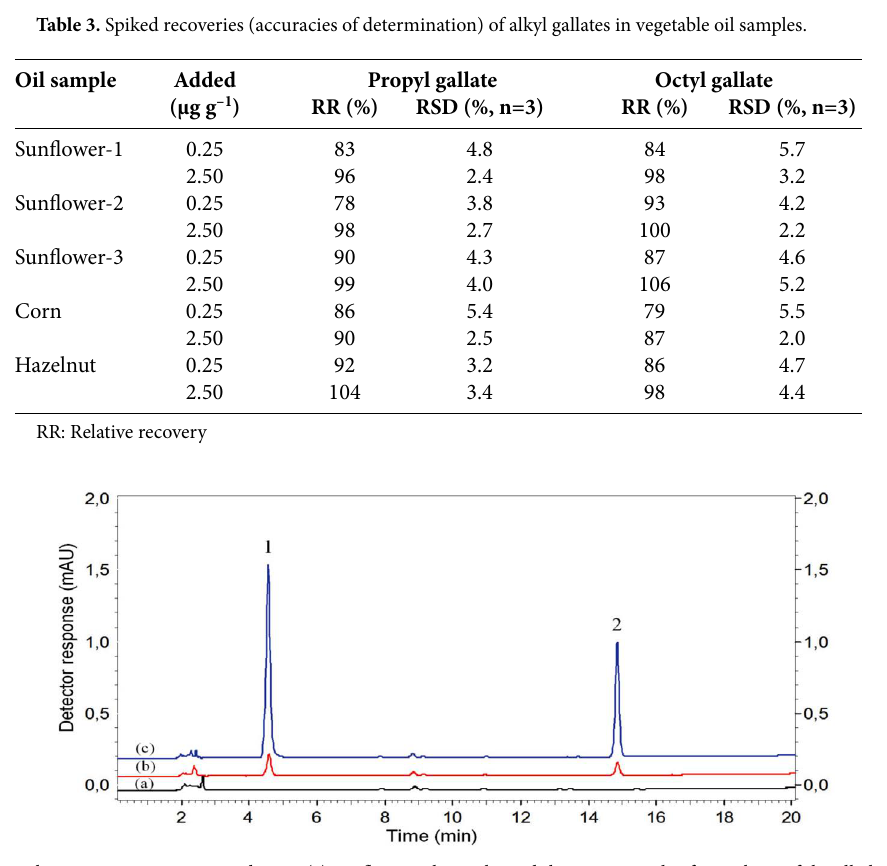
Figure 7. HPLC–UV chromatograms, corresponding to (a) sunflower oil sample, and the same sample after spiking of the alkyl gallates at the (b) 0.25 µg g –1 and (c) 2.5 µg g –1 levels. 1: Propyl gallate, 2: Octyl